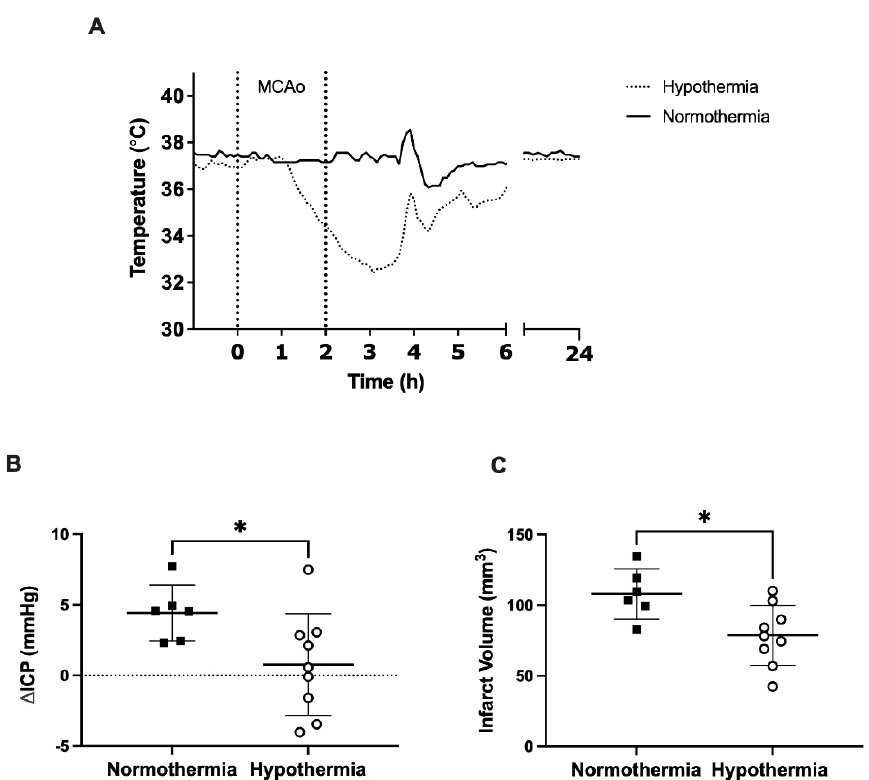
Figure 2. ( A ) Core temperature recordings during hypothermia and equivalent normothermia period. 0–2 h represent period of occlusion. Hypothermia treatment was initiated at 1 h. ( B ) Δ ICP from baseline to 18 h in the hypothermia treated and normothermia control animals. ( C ) Infarct volumes from H&E ‐ stained sections at 24 h post ‐ stroke in hypothermia treated and normothermia control animals. * p < 0.05.